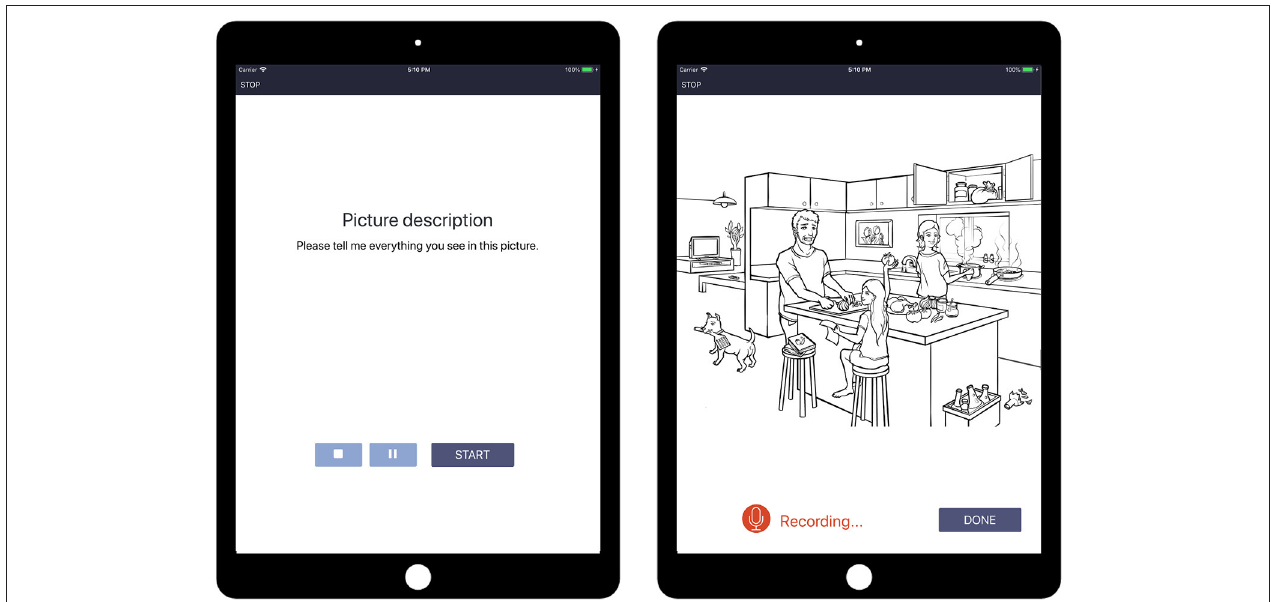
FIGURE 1 | Schematic of the picture description task, part of the Winterlight Assessment